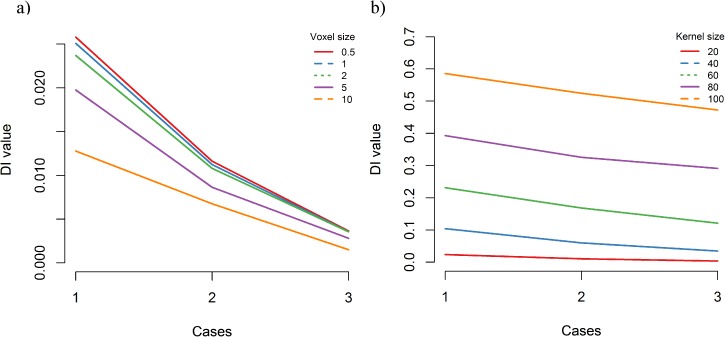
Sensitivity to method parameters shown on simulated data.Panel a) shows changes in method results for varying voxel sizes while kernel size is kept constant. Panel b) varies kernel size for a constant voxel size. The pattern of interaction value decreasing from case 1 through 2 to 3 is the same, regardless of voxel or kernel size.